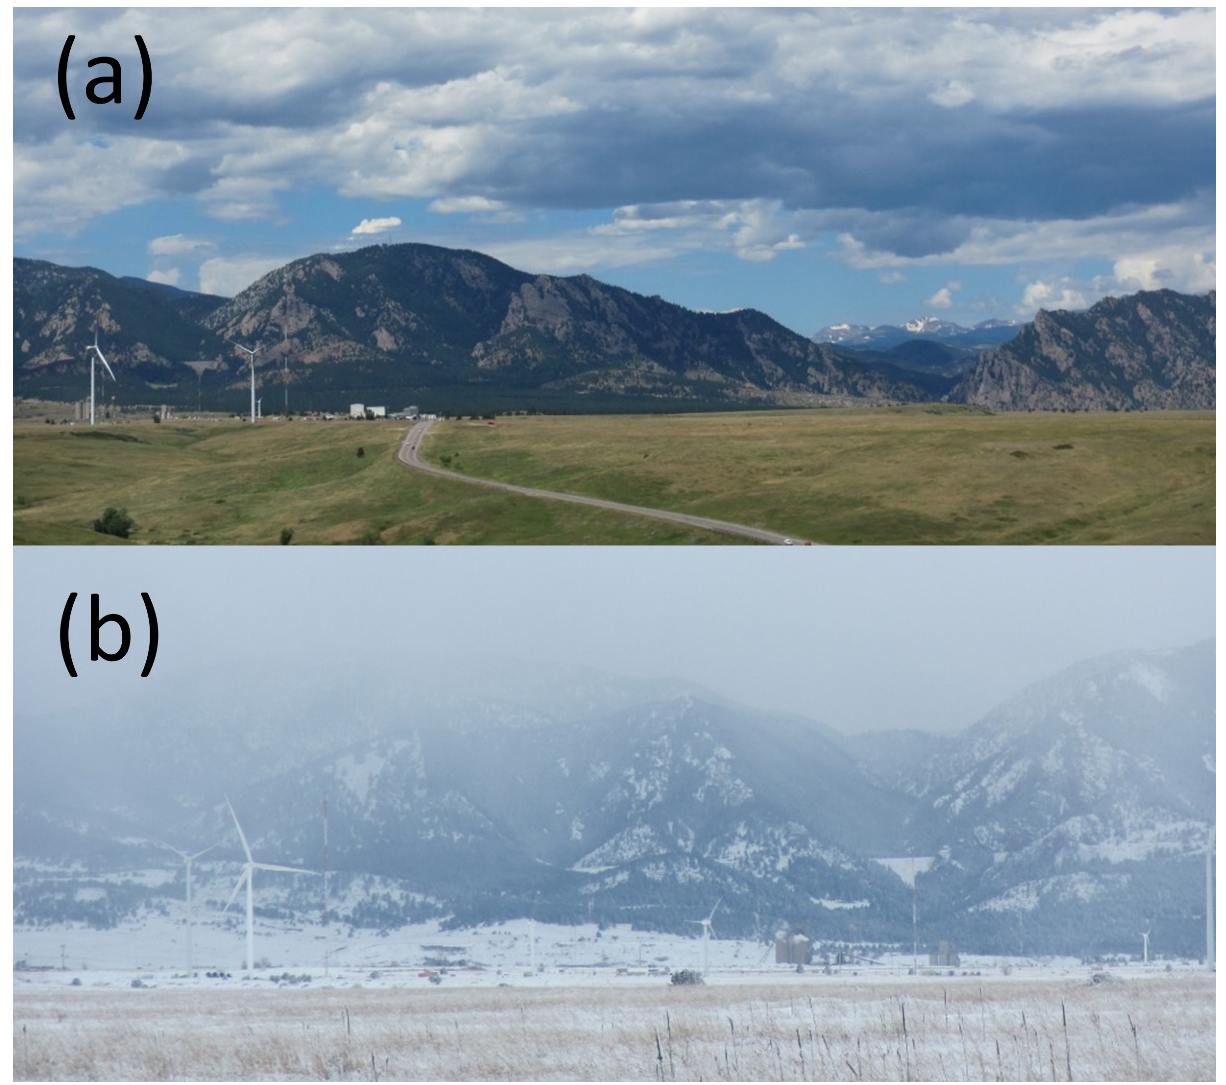
Figure 1. Wind turbines at the National Wind Technology Center, National Renewable Energy Laboratory, near Boulder, CO, USA. Ultraviolet (UV) illuminator systems to test the influence of dim UV illumination on flying animal presence and activity were installed during summer 2018 ( a ) and left in place and operating through the winter of 2018/2019 ( b ). Images by Paul Cryan.